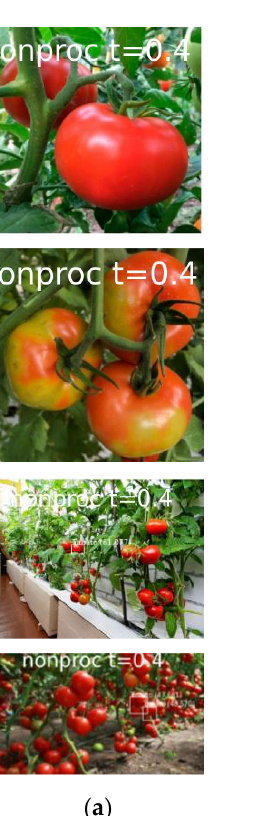
Figure 13. Detecting oranges on images by YOLOv3 without pre-processing ( a ) and with pre-processing ( b ).